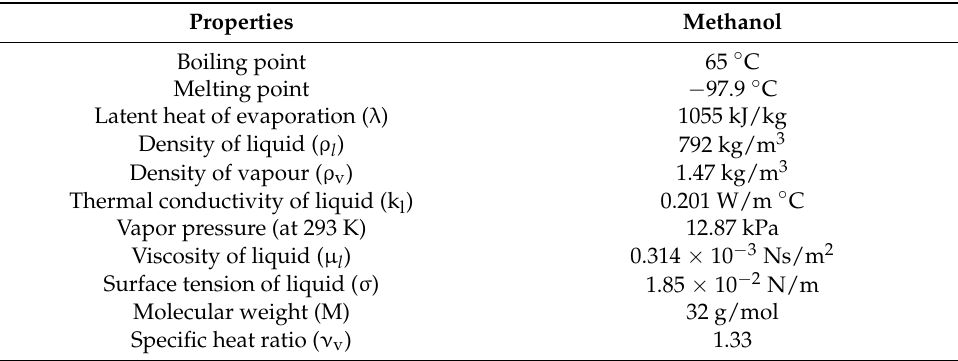
Table 2. Parametric levels used in Table 1. Thermo-physical properties of working fluid.